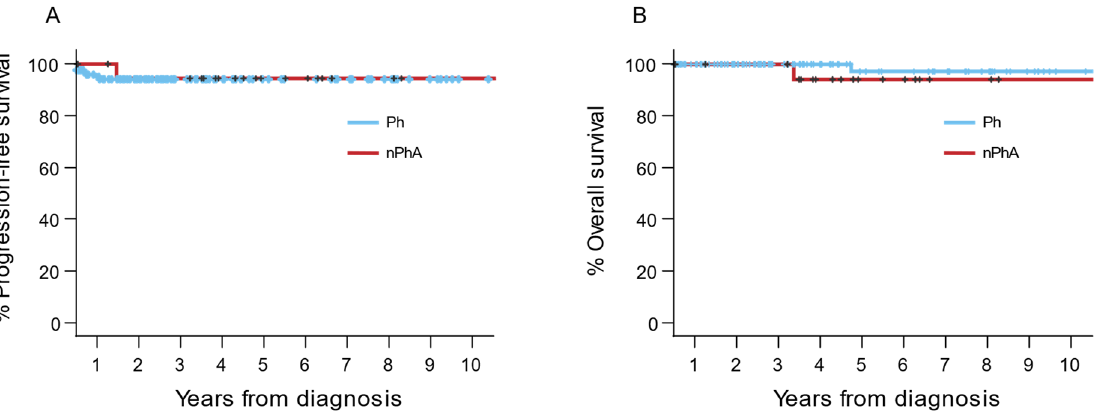
Figure 3. ( A ) Progression-free survival in patients carrying only the BCR::ABL1 translocation (Ph) compared to all patients with additional non-Philadelphia aberrations (nPhAs). ( B ) Overall survival in patients carrying only the BCR::ABL1 translocation (Ph) compared to all patients with additional non-Philadelphia aberrations